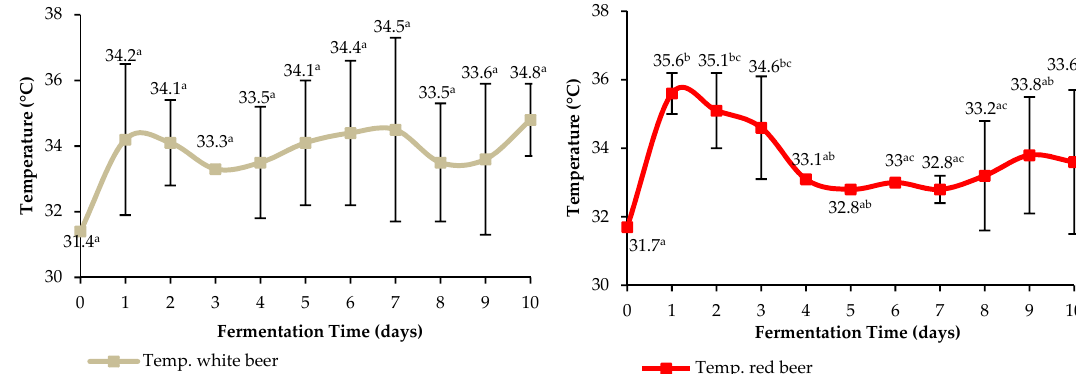
Figure 5. Evolution of temperature during fermentation of the indigenous sorghum beers. Mean values ( n = 3 repetitions) preceded by at least one common letter (a, b, c) were not significantly different ( p < 0.05). Bars represent standard deviations. The conductivity of the white and red beer samples is illustrated in Figure 7. The statistical analysis showed that there was no significant difference between the conductivity values of both beer samples during the fermentation process. The conductivity values varied between 800 µ S/cm and 920 µ S/cm for the white beer samples and from 898 µ S/cm to 1073 µ S/cm for the red beer